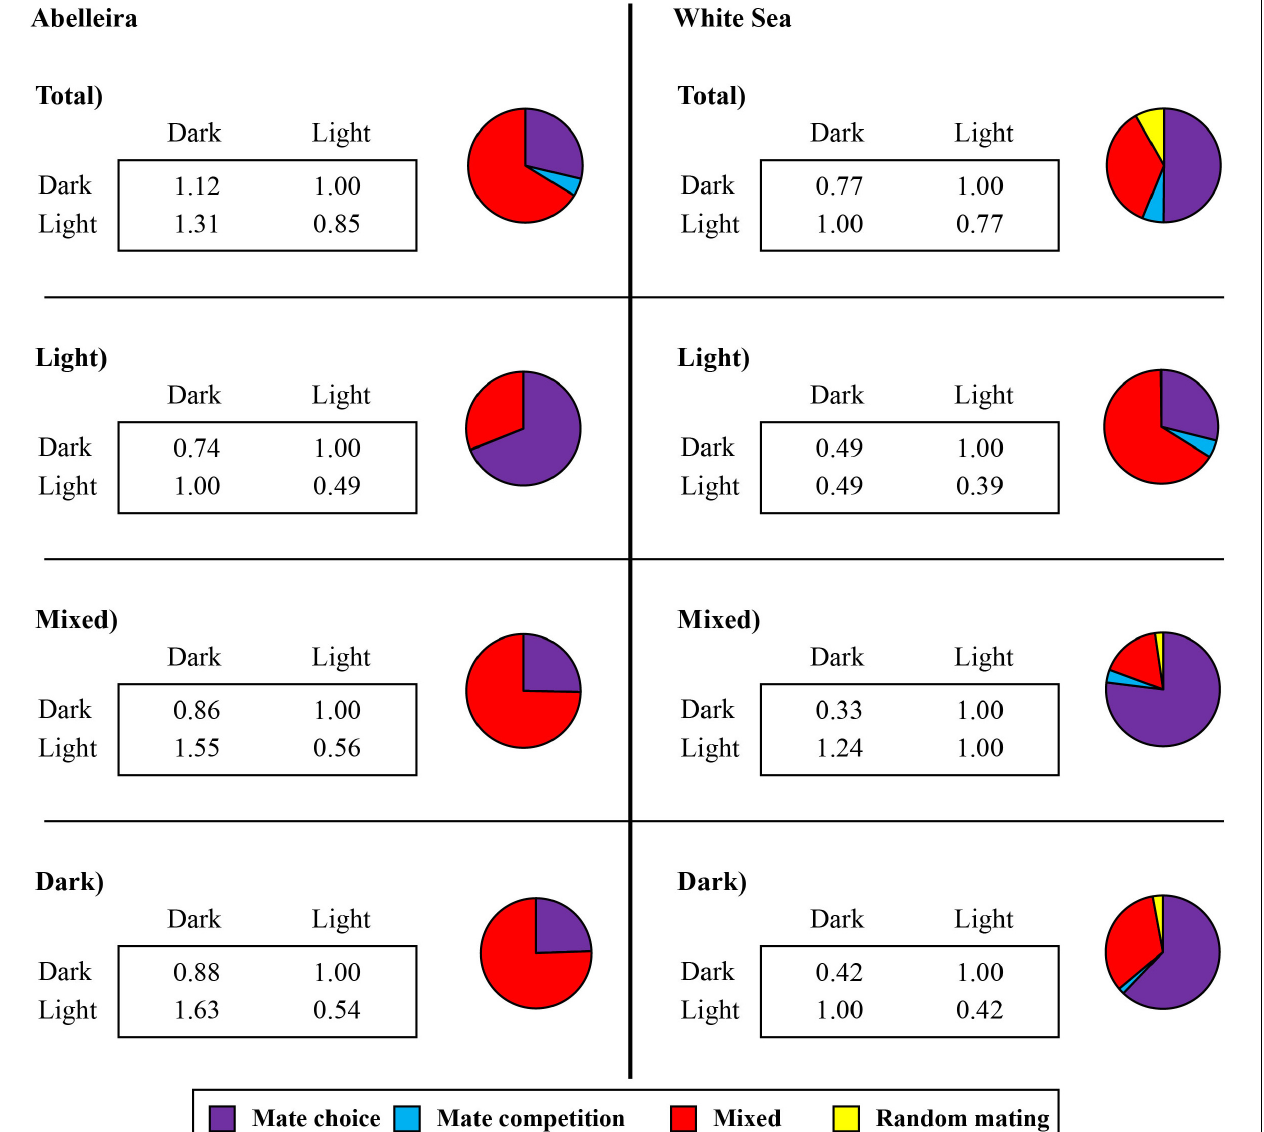
FIGURE 5 | Mutual mating propensities obtained for the best models in Abelleira and the White Sea in both total numbers and homogeneous groups, pooled across all years (Abelleira) and populations (White Sea). Male in columns and female in rows. Values within boxes are the best model mutual mating propensities for the four different mating combinations. Pie charts represent the sum of weights for mate choice, mate competition, mixed and random mating models (see Supplementary Table 2